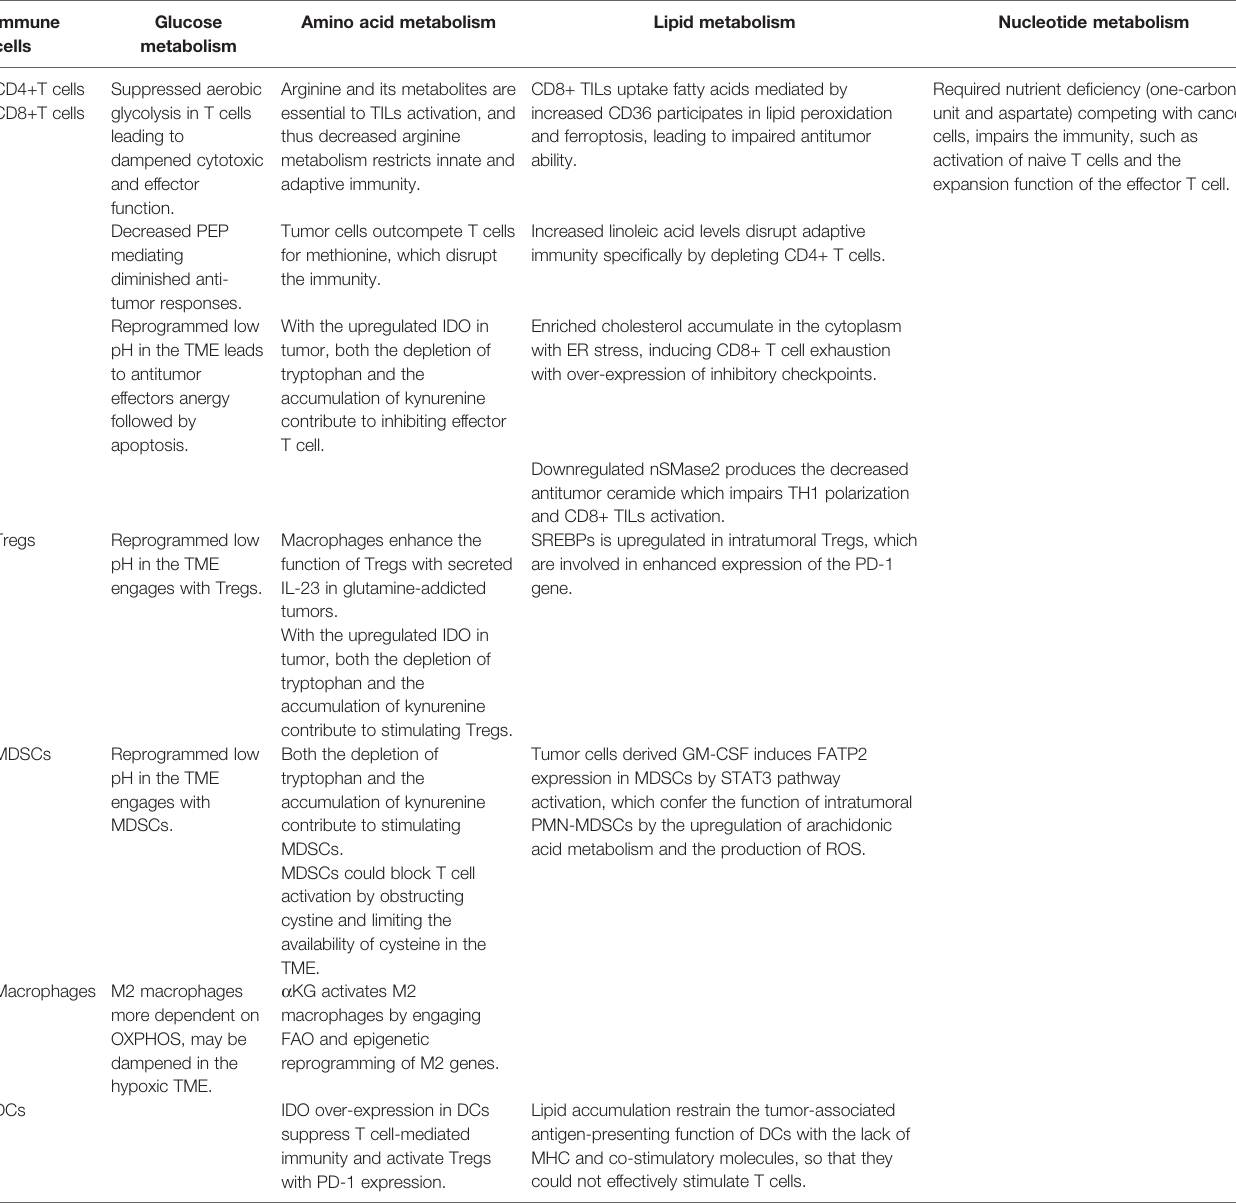
TABLE 1 | The metabolic reprogramming with different types of metabolism in immune cells in the TME. Immune Glucose Amino acid metabolism Lipid metabolism Nucleotide metabolism cells metabolism CD4+T cells CD8+T